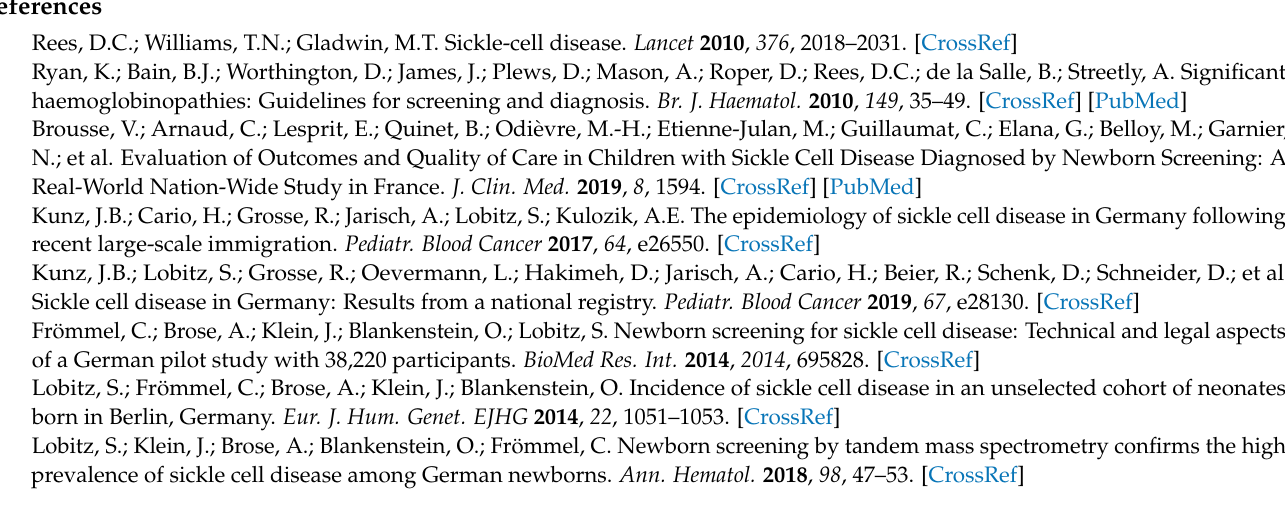
definitions. Figure S2: Treatment modalities in the total population. Figure S3: Frequency of acute chest syndrome in patients with SCD and of pneumonia in the general population. Table S1: Correc- tion factors for the overrepresentation of patients with SCD among AOK insures.